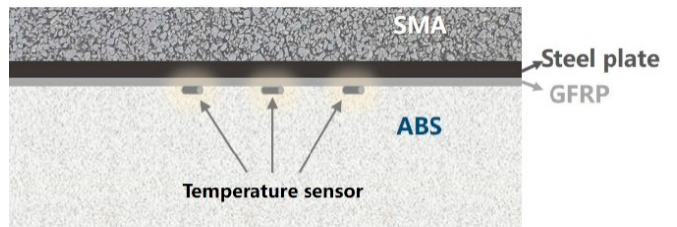
Figure 10. Schematic of the temperature sensor layout in the test piece.